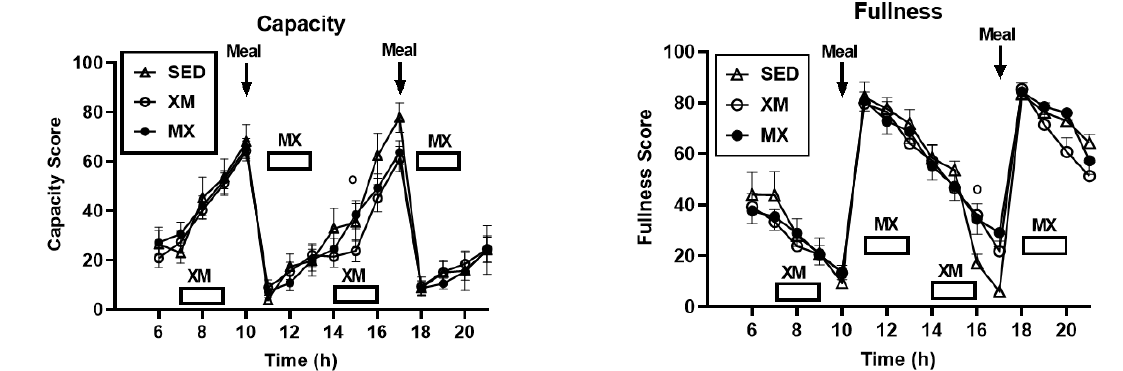
Figure 9. Visual analog scale ratings of hunger, desire to eat, capacity to eat, and fullness. Circles identify time slices when group differences were significantly different. XM = exercise before meals, MX = exercise after meals, SED = sedentary group.